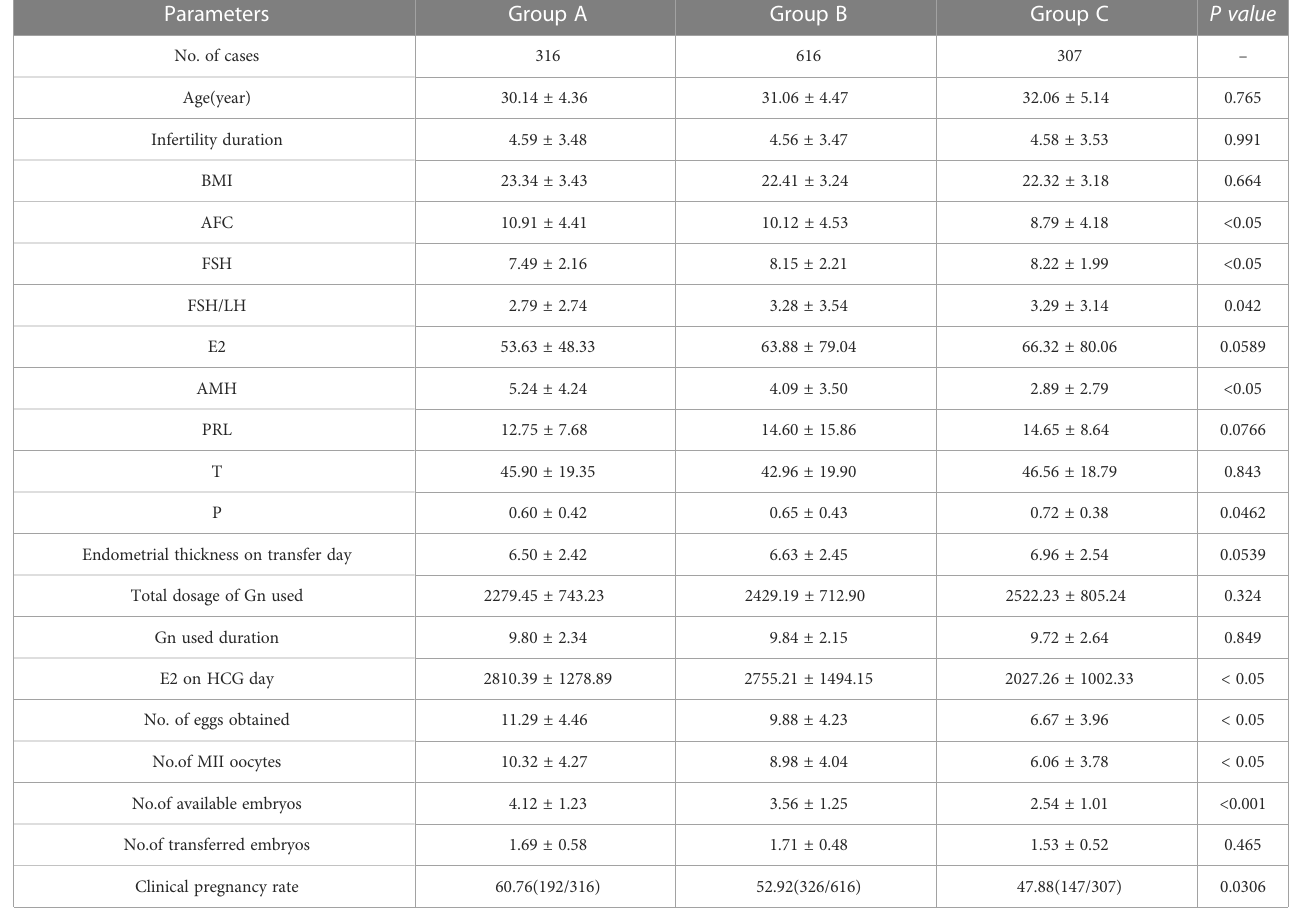
TABLE 1 Comparison of clinical data in each